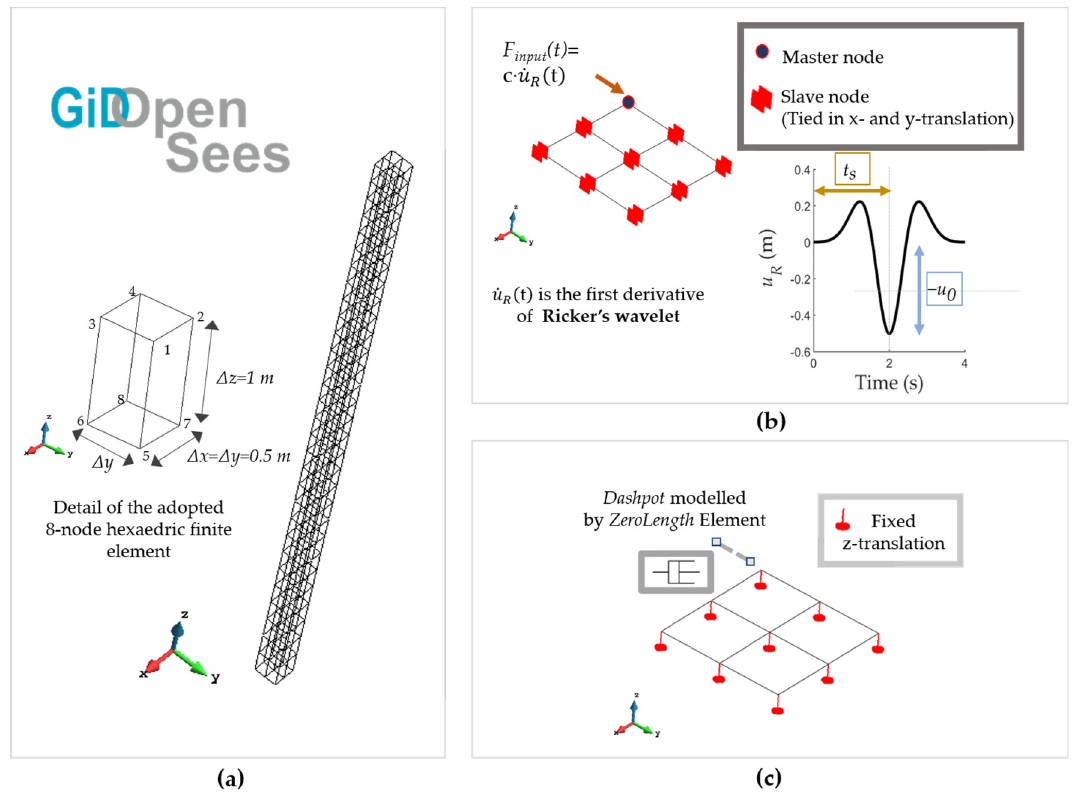
Figure 4. FE numerical modelling: ( a ) 3D model and finite element adopted, ( b ) input application at an end node of the base, with master-slave node for uniform excitation introduction, and ( c ) modelling of a viscous-elastic bedrock.